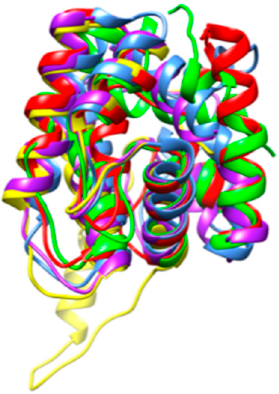
Figure 5. A. Superposition of the ribbon diagrams of odorant binding proteins from Apis mellifera (red), Bombyx mori (blue), Locusta migratoria (green), Onthophagus taurus (yellow) and Tenebrio molitor (purple).